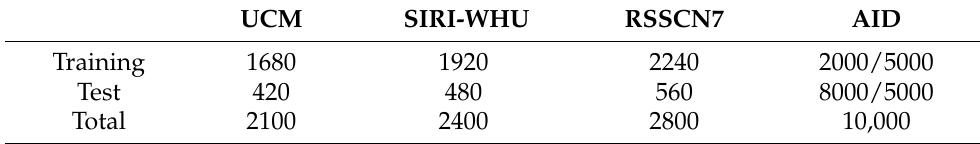
Table 2. The number of images in the test set and the training set in the three